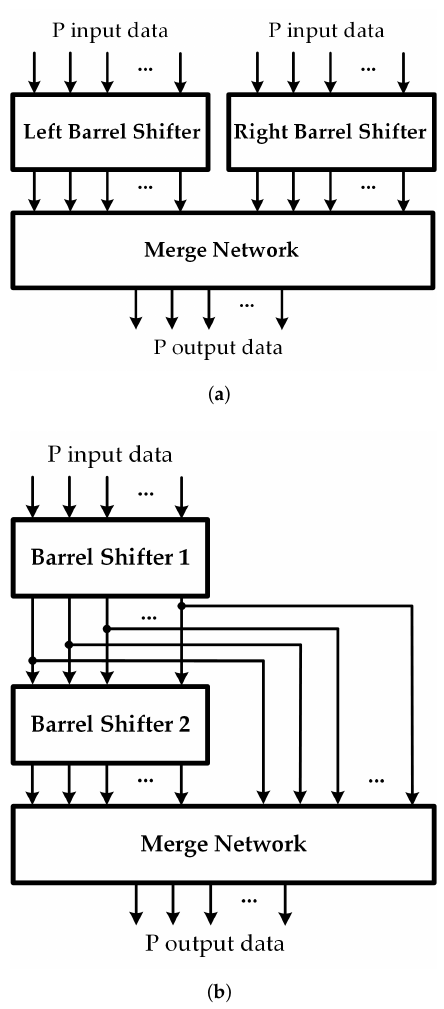
Figure 2. ( a ) RIP structure; ( b ) RIS